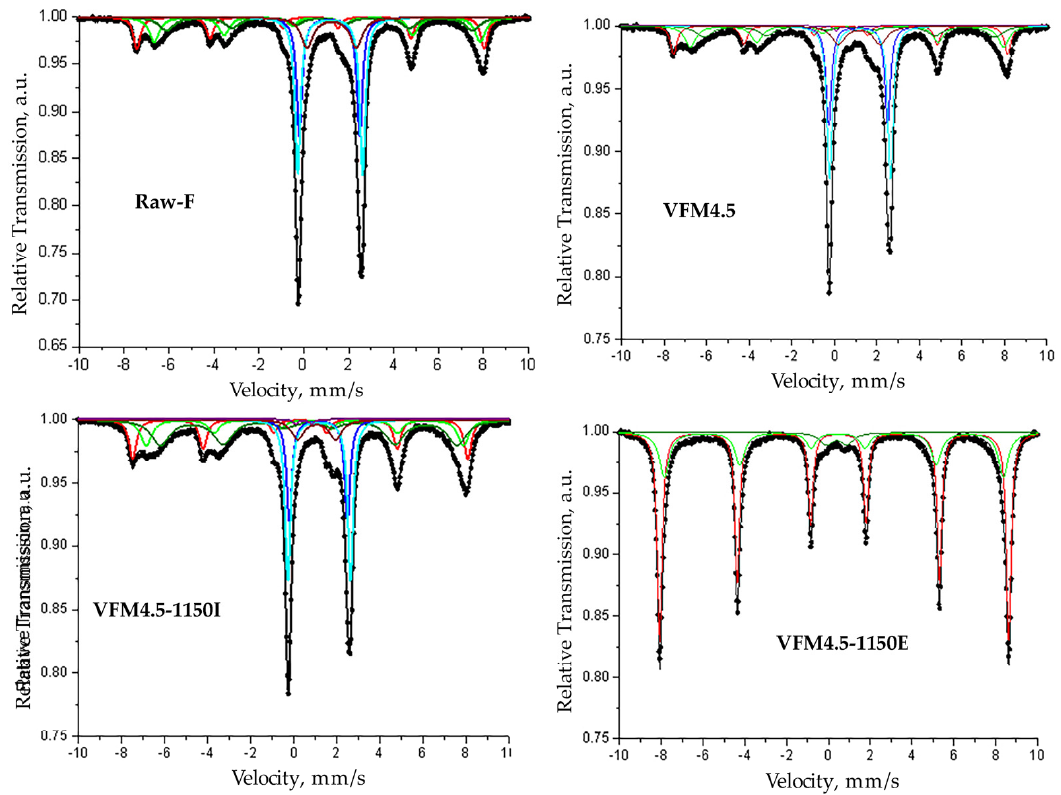
Figure 6. Mössbauer spectrums of geopolymer precursor (RAW-F), geopolymer series VFM4.5 and sample from interior and exterior part of VFM4.5 exposed to 1150 °C. Table 3. Mössbauer parameters of geopolymer precursor (RAW-F), geopolymer series VFM4.5 and sample from interior and exterior part of VFM4.5 exposed to 1150 °C.